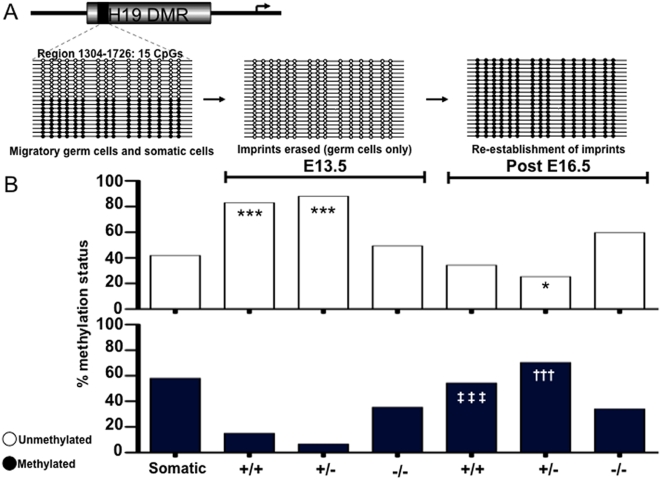
Methylation Marks at the H19 Imprinted Locus are disrupted in Germ Cells of Dazl Mutants.(A) Schematic of expected methylation status of 15 CpG islands in region 1304–1726 of the H19 differentially methylated region (DMR) (GenBank acc. No. U19619) at different time points in the lifecycle of male germ cell development. Open circles denote an unmethylated status of a CpG, while filled circles denote a methylated CpG. (B) Results of bisulphite sequencing displaying an average percent methylation status (y-axis) of 60 clones per datapoint (20 clones per individual sample, 3 replicates for each genotype/age) for both E13.5 and post E16.5 GFP-positive germ cells isolated by FACS. Clones that were hemi-methylated are not shown. ‘***’ denotes a very significant difference (P<0.001) in unmethylated status relative to somatic. ‘*’ denotes a statistically significant difference (P<0.05) in methylated status relative to somatic. ‘‡ ‡ ‡’ denotes an extremely significant difference (P<0.001) in methylated status with E13.5 Dazl+/+. ‘†††’ denotes an extremely significant difference (P<0.001) in methylated status with E13.5 Dazl+/−.